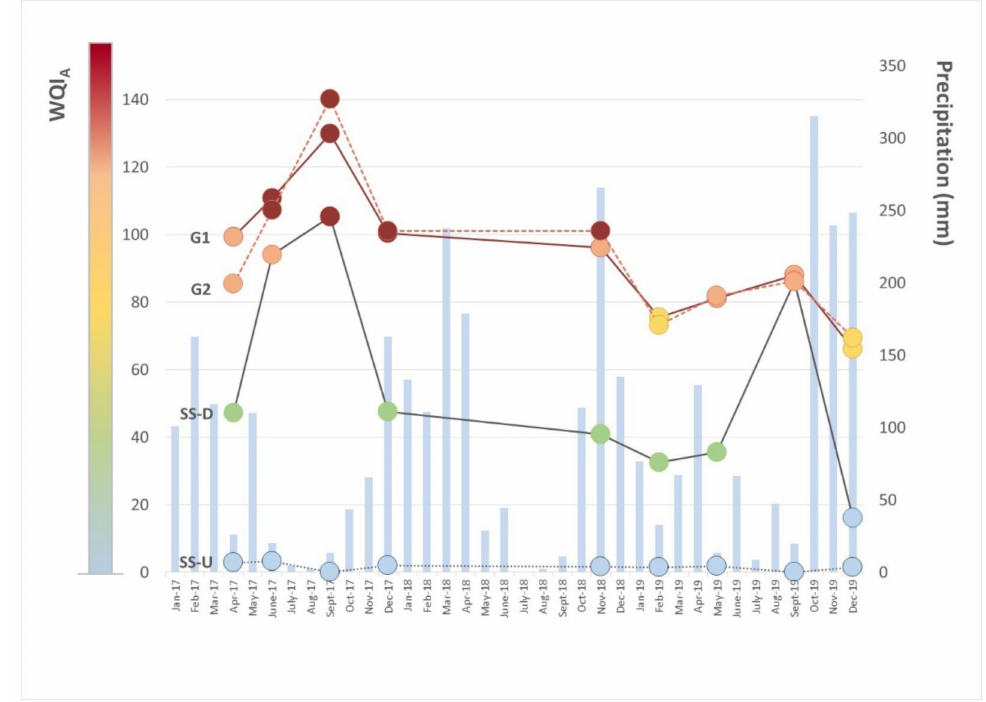
Figure 6. Relation between precipitation and water quality assessed by means of WQI A . Precipitation measured at Porto meteorological station. Data from the Portuguese Institute for Sea and Atmosphere, I. P. (IPMA, IP)